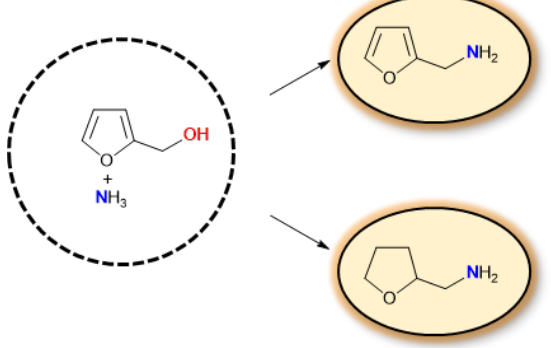
Table 1. Catalytic synthesis of furfuryl amine.